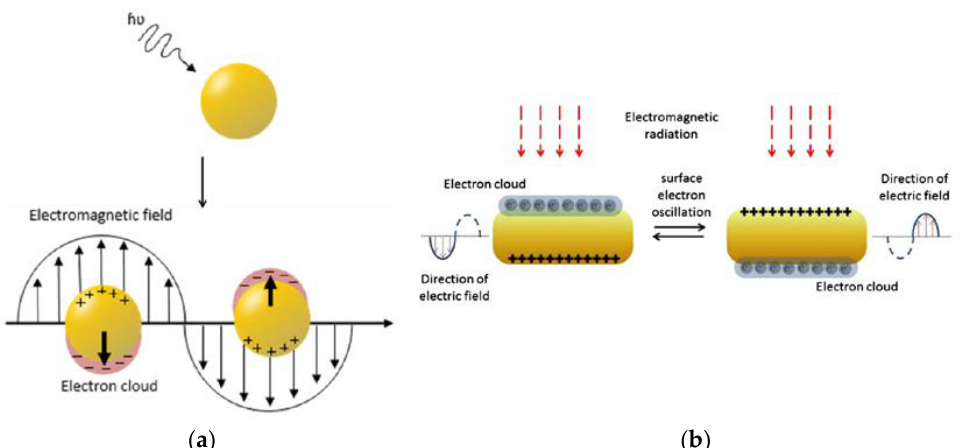
Figure 14. Schematic representation of the surface plasmon resonance (SPR) effect in ( a ) gold nanoparticles (adapted from ref. [99]) ( b ) gold nanorods (adapted with permission from ref. [85]. Copyright 2022, Elsevier).